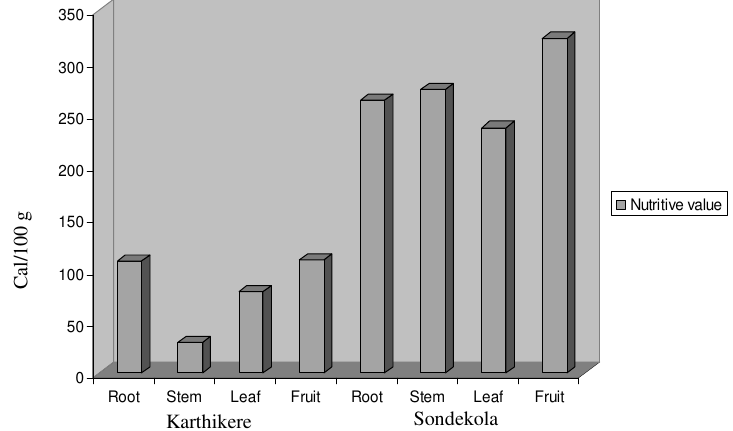
Figure 5. Variation of nutritive values of the root, steam, leaf and fruit samples of Withania somnifera ( Linn.) Dunal at Karthikere and Sondekola of Karnataka,